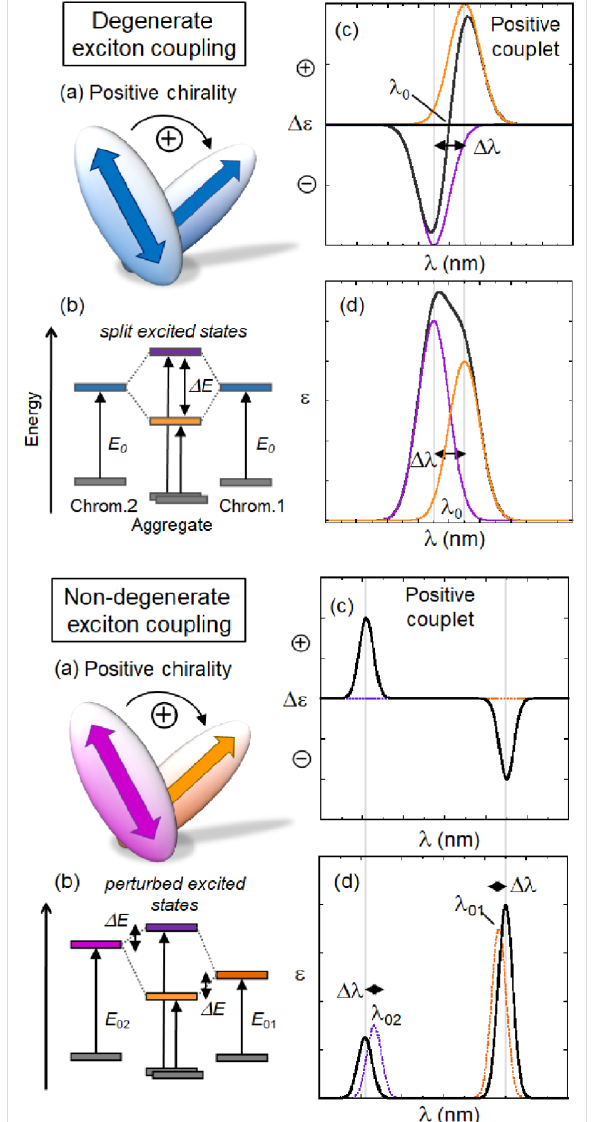
Figure 3: Exciton coupling mechanism in its degenerate (top) and non- degenerate version (bottom). a) Chirality defined by transition moments located on the two chromophores. A positive chirality corre- sponds to a clockwise direction when rotating the transition dipole in the front onto that in the back. b) Splitting of excited states due to exciton coupling. Notice the stronger effect in the degenerate case. c) ECD couplet originating from exciton coupling. The sign of the couplet (i.e., of its long-wavelength branch) is the same of the chirality (exciton chirality rule). In the degenerate case, the couplet is centered in correspondence of the chromophore transition at λ 0 . In the non- degenerate case, each band is localized close to one chromophore transition ( λ 01 and λ 02 ). d) Absorption spectra originating from exciton coupling. The wavelength splitting Δλ is related to the energy splitting Δ E